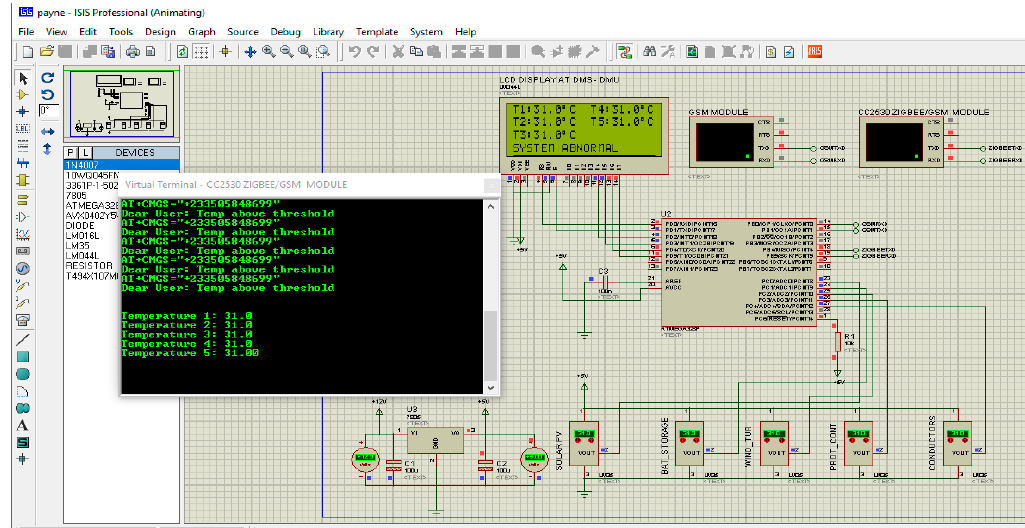
Figure 11. System abnormal condition above maximum settings.